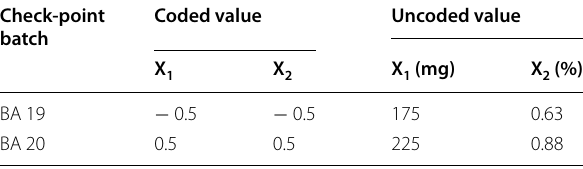
Table 2 Check-point batch